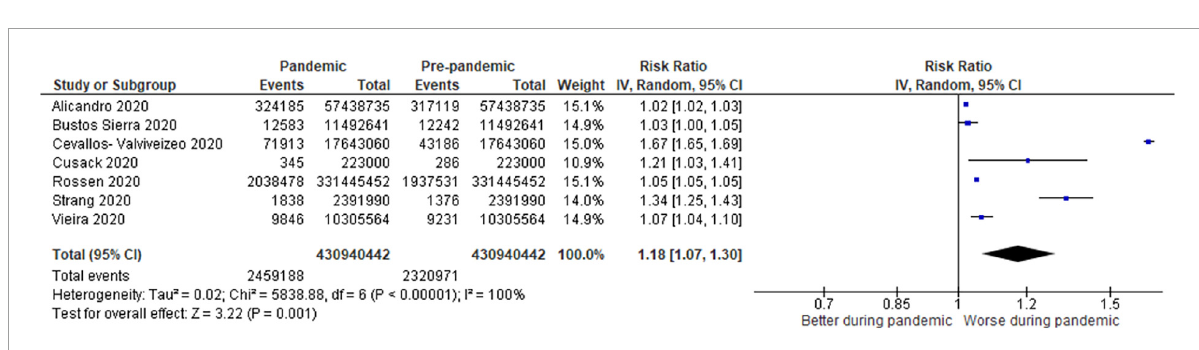
FIGURE4 Forest plot for non-COVID-19 mortality. CI, confidence intervals; COVID-19, coronavirus disease 2019; IV, inverse